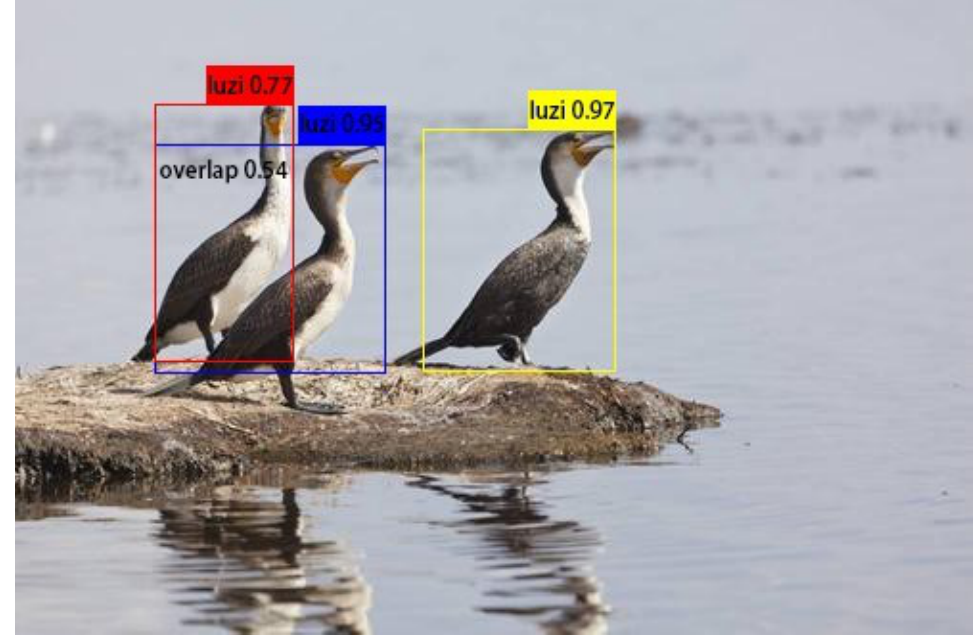
Figure 3. I ou overlap